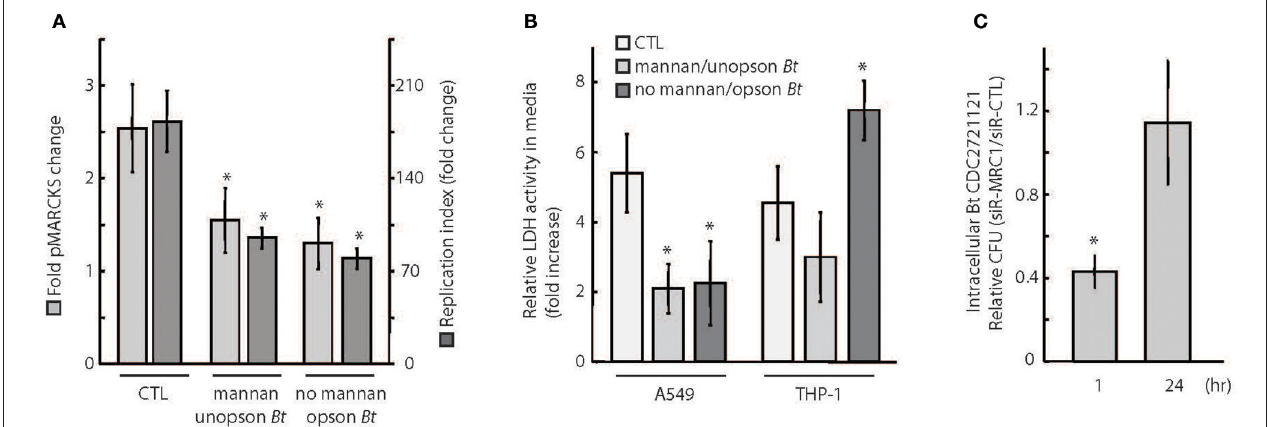
FIGURE 5 | Phagocytosis receptor usage determines the efficiency of intracellular Burkholderia proliferation. (A) A549 cells were (1) incubated with 3 mg/ml soluble mannan for 30 min and then infected with unopsonized Bt CDC2721121 at MOI 50, (2) not treated with mannan and infected with Bt CDC2721121 coated with anti- B.thailandensis rabbit serum (opson Bt ), or (3) not treated with mannan and uninfected (CTL). pMARCKS levels in bacteria-infected cells were quantified and compared to uninfected cells. In parallel, A549 cells were collected after 2 h of infection for determination of intracellular bacterial counts. These cells were treated with 250 µ g/ml kanamycin for 3 h to inhibit extracellular bacterial growth and incubated overnight in antibiotic-free media. At 24 h post-infection, a second set of samples were collected, and colony forming units (CFU) were calculated from limiting dilutions of the cell lysates incubated on nutrient agar for 24 h at 37 ◦ C. The replication index of intracellular Bt CDC2721121 was calculated as the CFU fold change at 24 vs. 2 h post-infection. The average and standard deviation from three independent experiments are shown. The “*” denotes statistical significance ( p < 0.05) for fold change in pMARCKS and replication index in host cells treated with mannan or pathogen coated with serum, compared to CTL samples. (B) A549 and THP-1 cells were treated as described in (A) , and LDH activity was measured in conditioned media 2 h post infection. After treatment with kanamycin (250 µ g/ml) for 3 h, host cells were incubated for 24 h in antibiotic-free media and a second LDH measurement was taken. Relative LDH activity was determined as fold change between the 24 h and 2 h time points post-infection. The average and standard deviation from three independent experiments are shown. The “*” denotes statistical significance ( p < 0.05) for relative LDH activity in experimental samples compared to untreated (CTL) samples. (C) A549 cells were treated with 25 nM siRNA targeting MRC1 or with non-targeting (CTL) siRNA and were infected with unopsonized Bt CDC2721121 at MOI 50. At 1 h and 24 h post-infection, cells were lysed with 0.1% Triton, and colony forming units (CFU) were calculated from limiting dilutions of the cell lysates incubated on nutrient agar for 24 h at 37 ◦ C. The ratio of CFU corresponding to intracellular bacteria from siR-MRC1 treated cells vs. cells treated with non-targeting siRNA is shown for each time point. The average mean and standard deviation from three independent experiments are shown. The “*” denotes statistical significance ( p < 0.05) in number of CFUs between 1 and 24